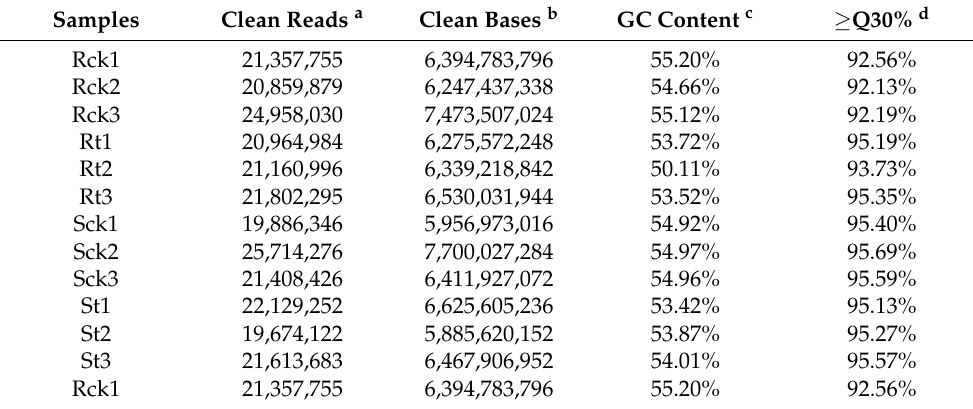
Table 2. Sequencing data